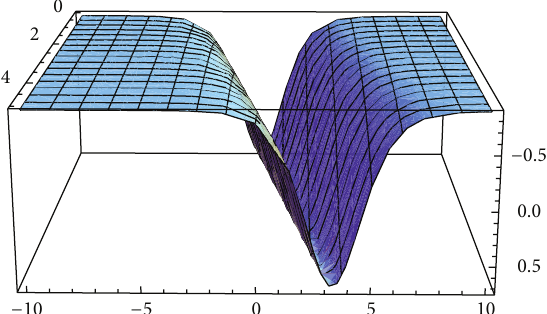
Figure 5: Travelling waves solutions (45) are plotted: dark solitary waves.